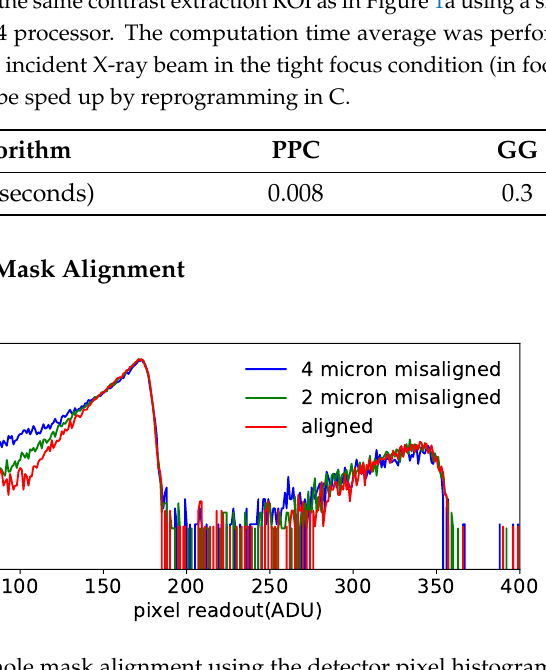
Figure A1. Pinhole mask alignment using the detector pixel histogram. Plotted in green and blue are the histograms when shifting the mask horizontal position by 2 µ m and 4 µ m from the aligned position